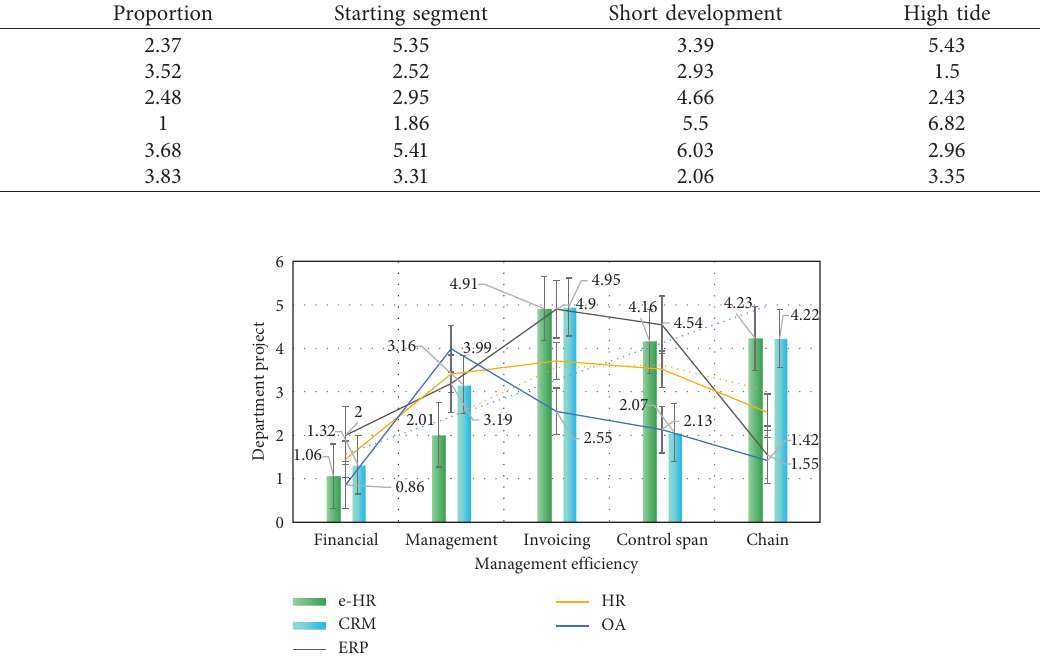
Figure 8: The relationship between company management tools and benefits. Table 10: Relationship data between company management tools and